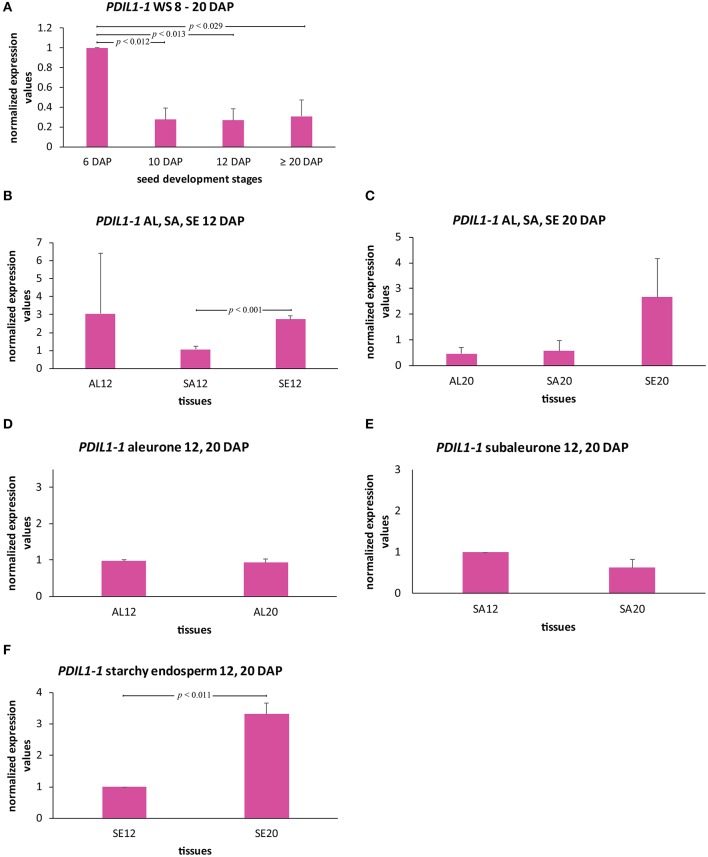
Spatio-temporal quantification of HvPDIL1-1 transcripts in developing barley endosperm. (A) Bar graph describes the average over three biological replicates of the normalized transcripts from HvPDIL1-1 in the whole seed (WS) at 6, 10, 12, and ≥20 DAP. (B–F)
HvPDIL1-1 transcript quantification in all tissues at 12 DAP (B), at ≥20 DAP (C), and in aleurone (D), subaleurone (SA) (E), and starchy endosperm (F) at 12 and 20 DAP. For statistical analyses we performed a Student's t-test (n = 3). Bars represent standard deviation. Note the indicated p-values.